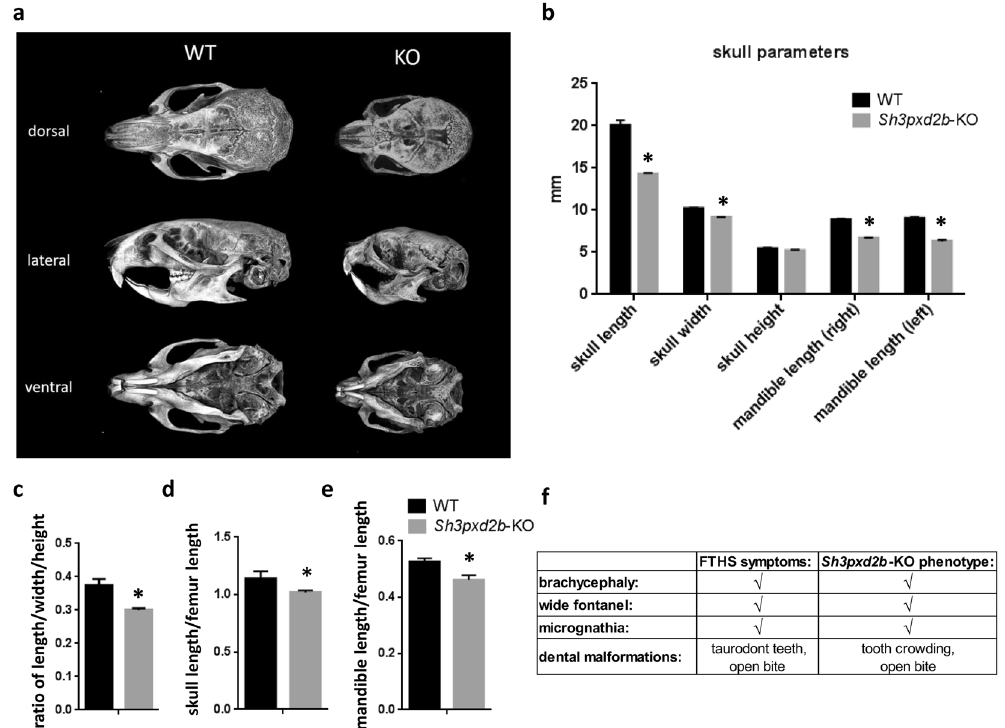
Figure 1. Cephalometric analysis of the cranial models of wild type and Sh3pxd2b -KO mice. ( a ) The dorsal, lateral and ventral views of representative 3D renderings of the skulls from 8-month-old wild type and Sh3pxd2b -KO mice show significant dysmorphology. ( b ) Sh3pxd2b -KO mice were compared to their genotypically wild type littermates to evaluate several parameters, including skull length, width, and height and mandible length. The anatomical landmark points used for the measurements are listed in the Methods section. Relative comparisons of the individual skull parameters: the skull length/width/height ratio ( c ), the skull length/ femur length ratio ( d ) and the mandible length/femur length ratio ( e ). The differences in the data were analyzed by Student’s t-test and three Sh3pxd2b -KO and three wild type mice were used. * p < 0.05. ( f ) Comparison of the dysmorphologies observed in skulls from Sh3pxd2b -KO mice with those reported in FTHS